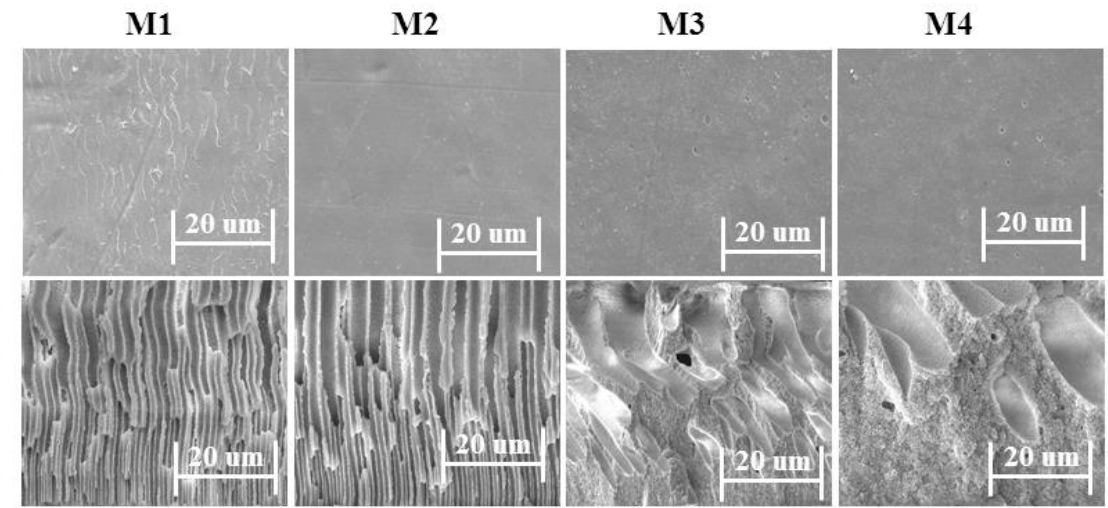
Figure 9. SEM micrographs of surface ( top ) and cross-section ( bottom ) of the prepared porous membranes.